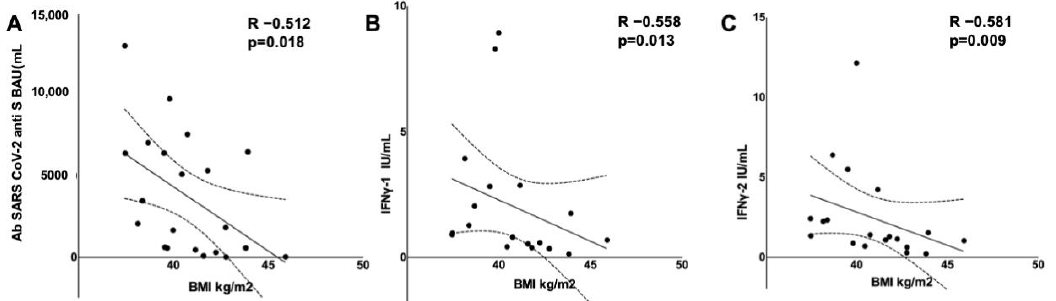
Figure 1. Scatterplots showing that baseline BMI is inversely correlated with humoral ( A ) and cell-mediated immune response after an mRNA COVID-19 vaccination ( B , C ).